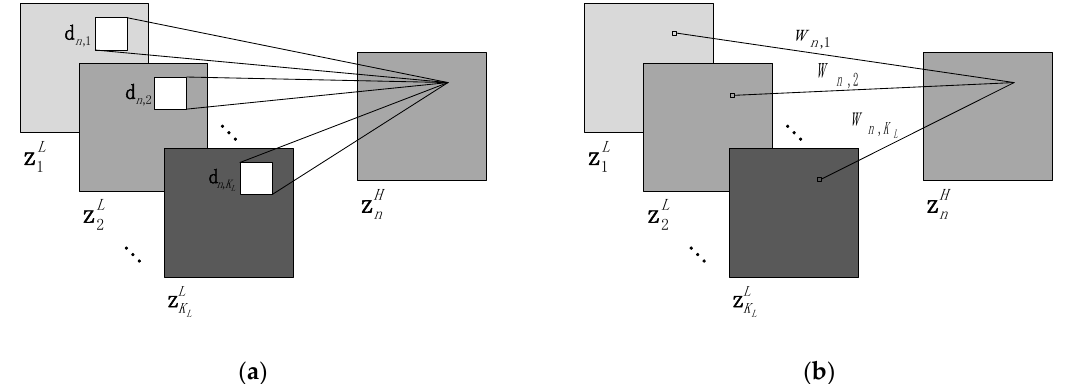
Figure 2. The relationship between convolutional and linear mapping functions. ( a ) Convolutional mapping architecture. ( b ) Linear mapping architecture.